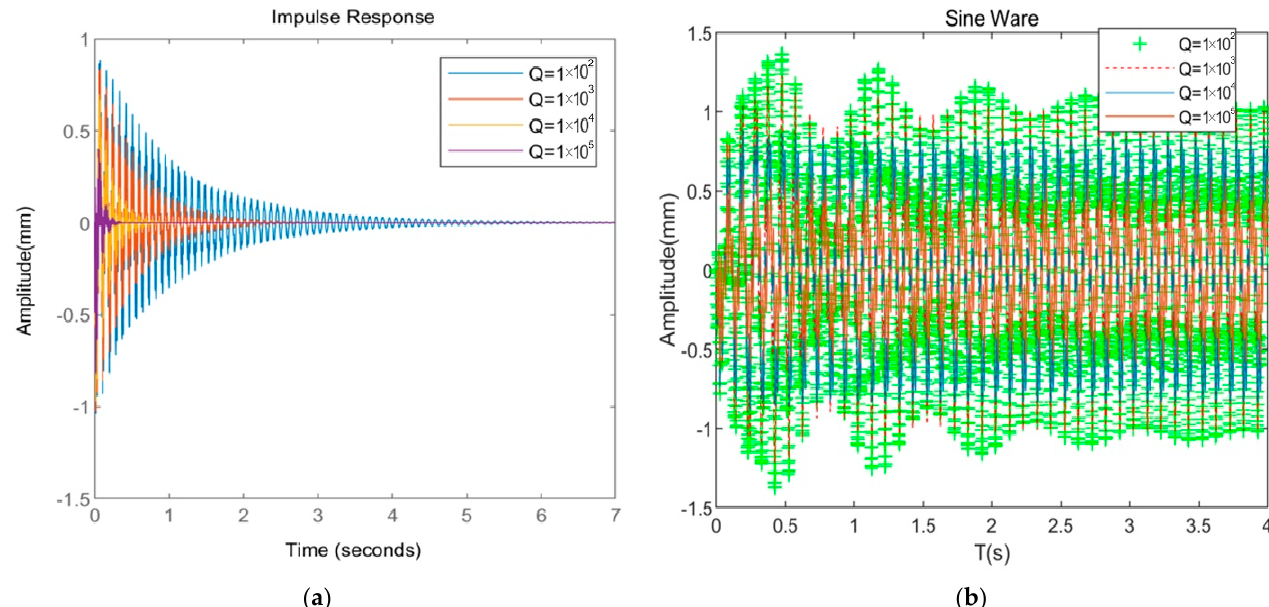
Figure 14. Comparison of system response with different Q-matrix coefficients. ( a ) System response under impulse excitation; ( b ) system response under sine wave.